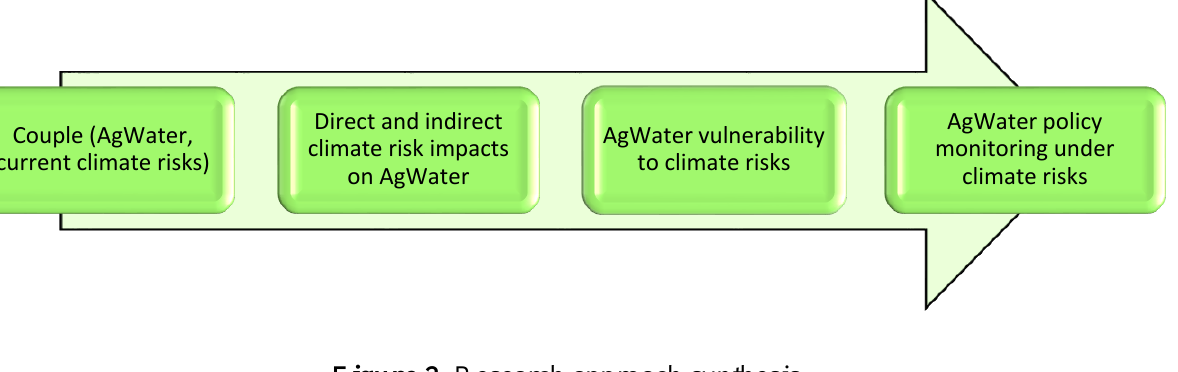
Figure 2. Research approach